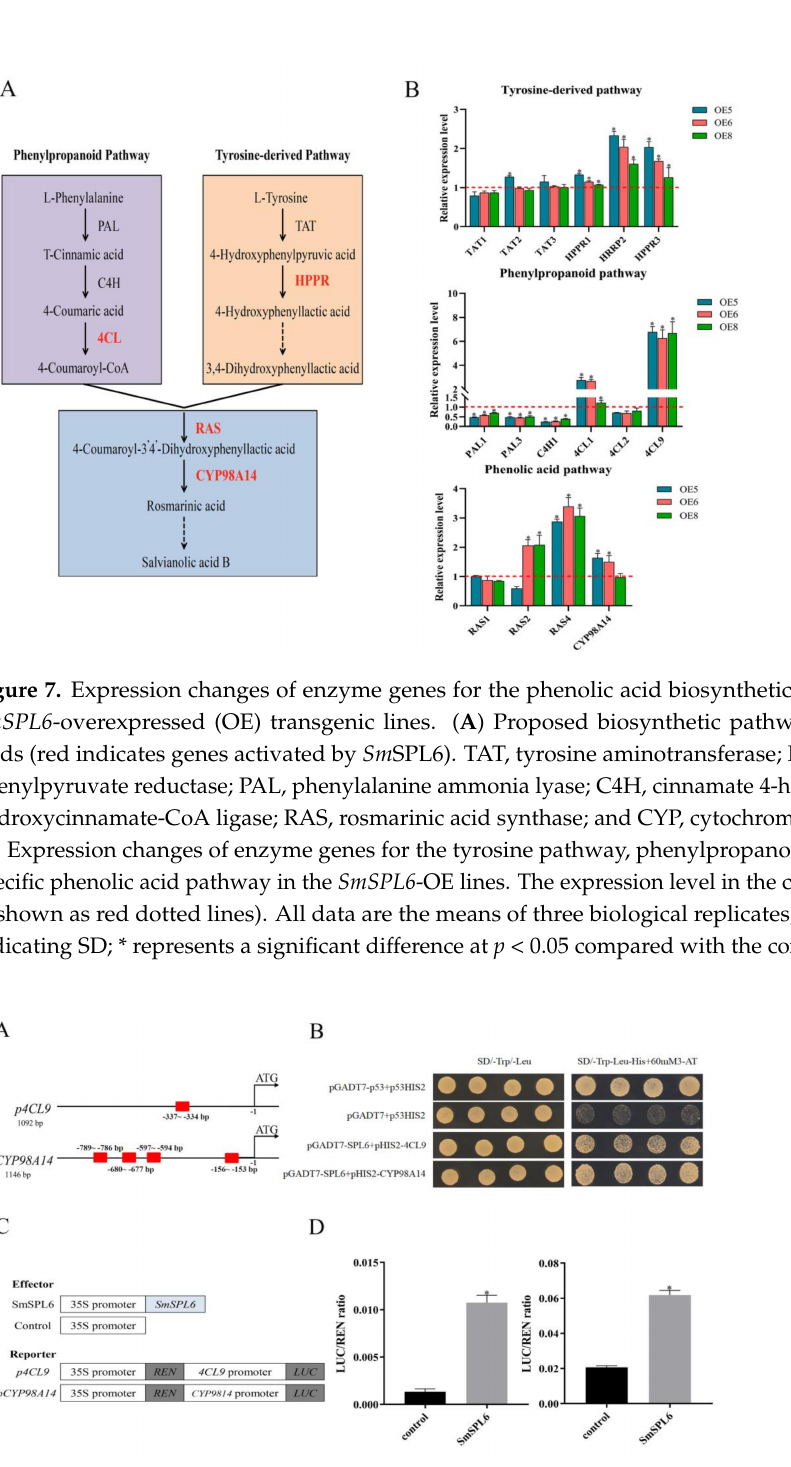
Figure 8. Sm SPL6 binds to the promoter regions of Sm4CL9 and SmCYP98A14 and activates their expression. ( A ) GTAC motifs in the promoter regions of Sm4CL9 and SmCYP98A14 . Red rectangles represent the GTAC motif. ( B ) Yeast one-hybrid detected interactions between the Sm SPL6 and the promoters of Sm4CL9 and SmCYP98A14 . The p53HIS2/pGADT7-p53 and p53HIS2/pGADT7 served as positive and negative controls, respectively. ( C ) Schematic diagram of constructs used in assays of transient transcriptional activity. ( D ) Sm SPL6 activates the expression of Sm4CL9 and SmCYP98A14 . Effector SmSPL6 was co-transformed with p4CL9 -LUC/ pCYP98A14 -LUC reporters. All data are the means of three biological replicates, with error bars indicating SD; * represents a significant difference at p < 0.05 compared with the